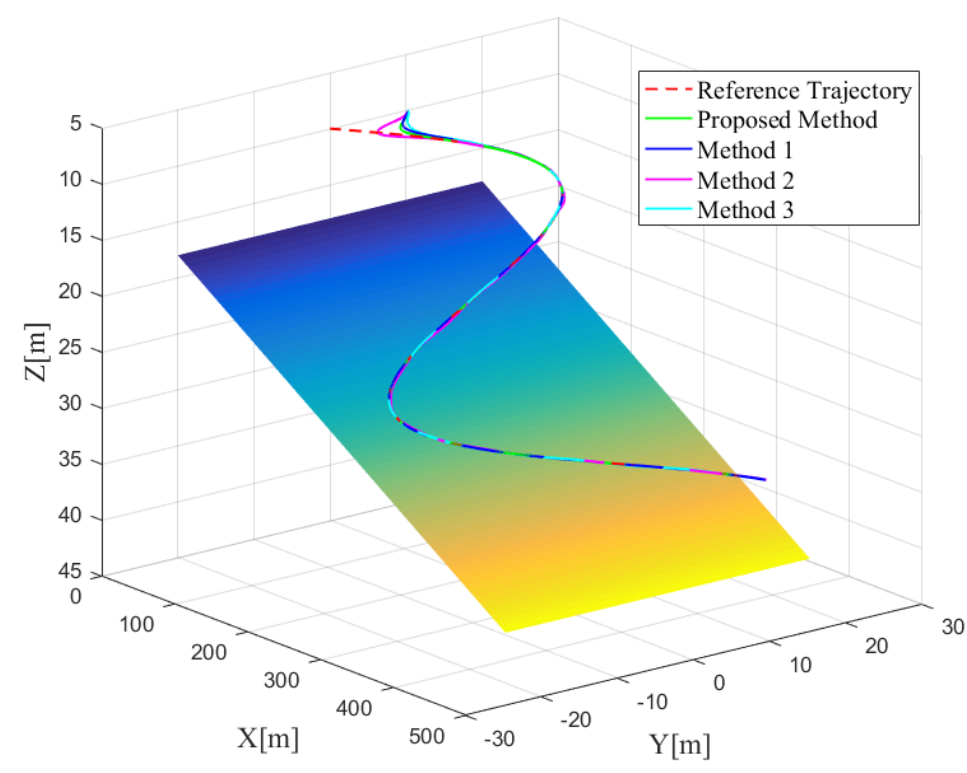
Figure 9. 3D trajectory tracking comparison of Case 2.